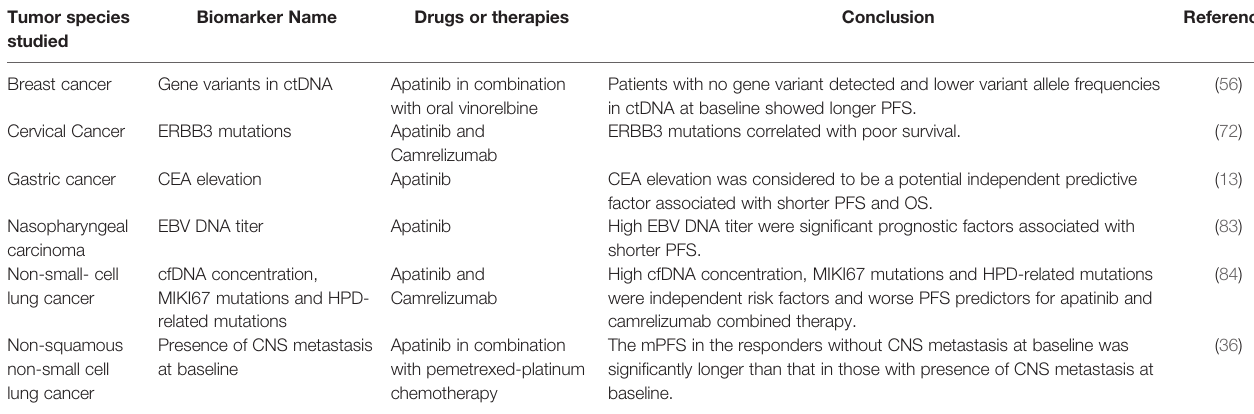
TABLE 8 | Response biomarkers of apatinib associated with poor outcomes in the treatment of malignancies. Tumor species